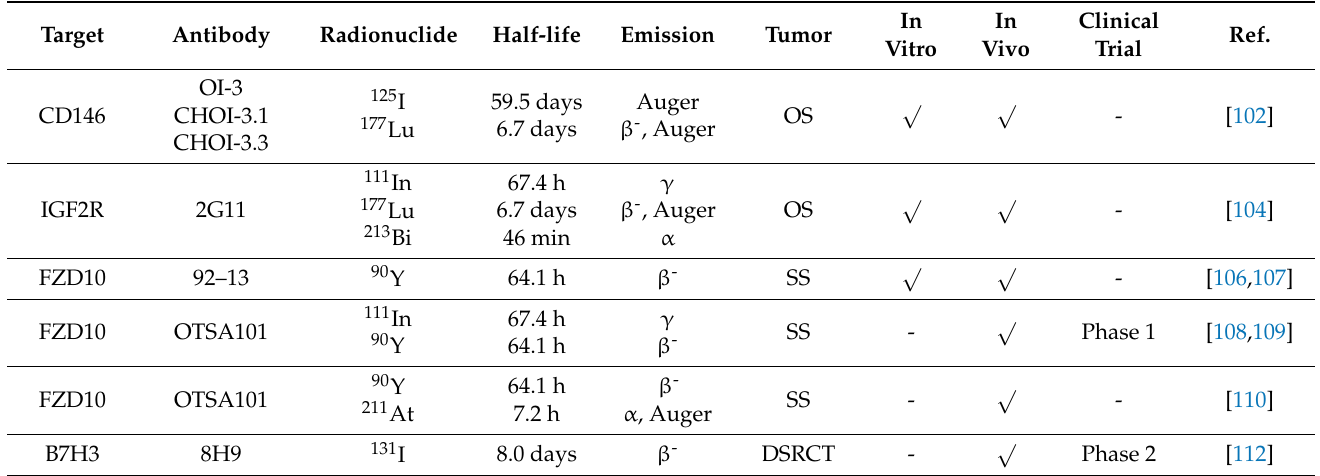
Table 3. Radioimmunoconjugates tested for sarcoma